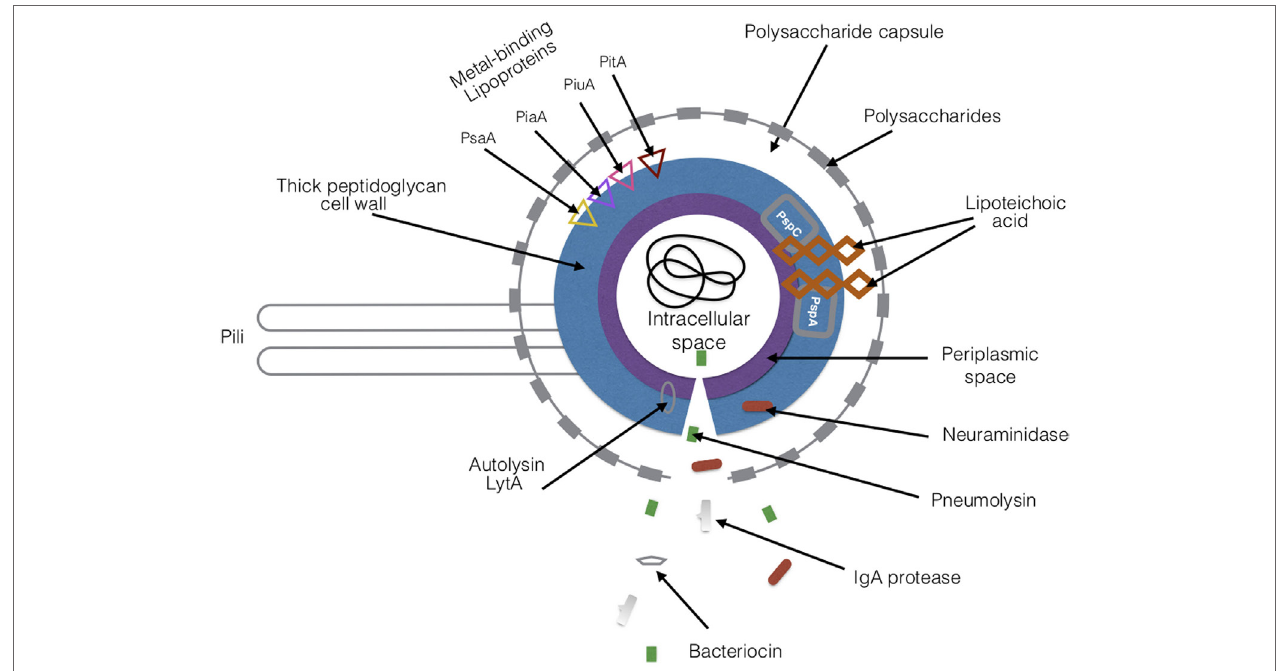
FigURe 4 | Virulence factors of Streptococcus pneumoniae. There are a variety of proteins and toxins that are expressed by S. pneumoniae that drive its pathogenesis. The major virulence factors are highlighted in the figure. Abbreviations: PsaA, pneumococcal surface adhesin A; PspA, pneumococcal surface protein A; PspC, pneumococcal surface protein C; PiaA, pneumococcal iron acquisition A; PiuA, pneumococcal iron uptake A; PitA, pneumococcal iron